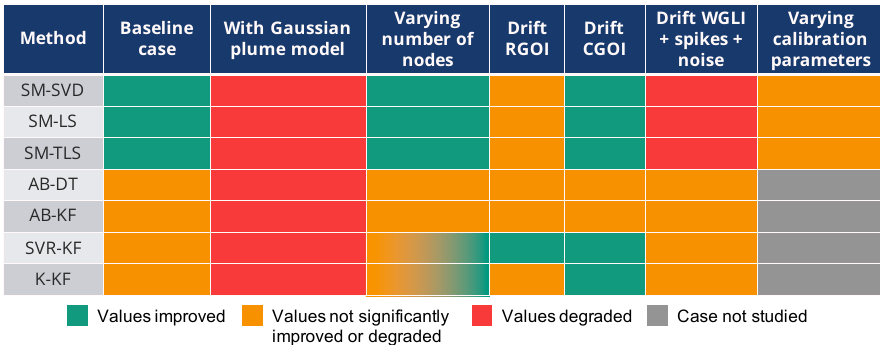
Figure 19. Summary of the results observed by changing the parameters of the baseline case study which was built with a 2D Gaussian function to model the measurand, with the WGLI drift model applied to the measured values of the instruments, with 16 nodes in the network and the values indicated in Section 4 for the parameters of the in situ calibration algorithms. The improvements are judged relatively to results of the baseline case, recalled in the first column. Thus, this table does not indicate that the corrected values are very close to the true values when the measured values are